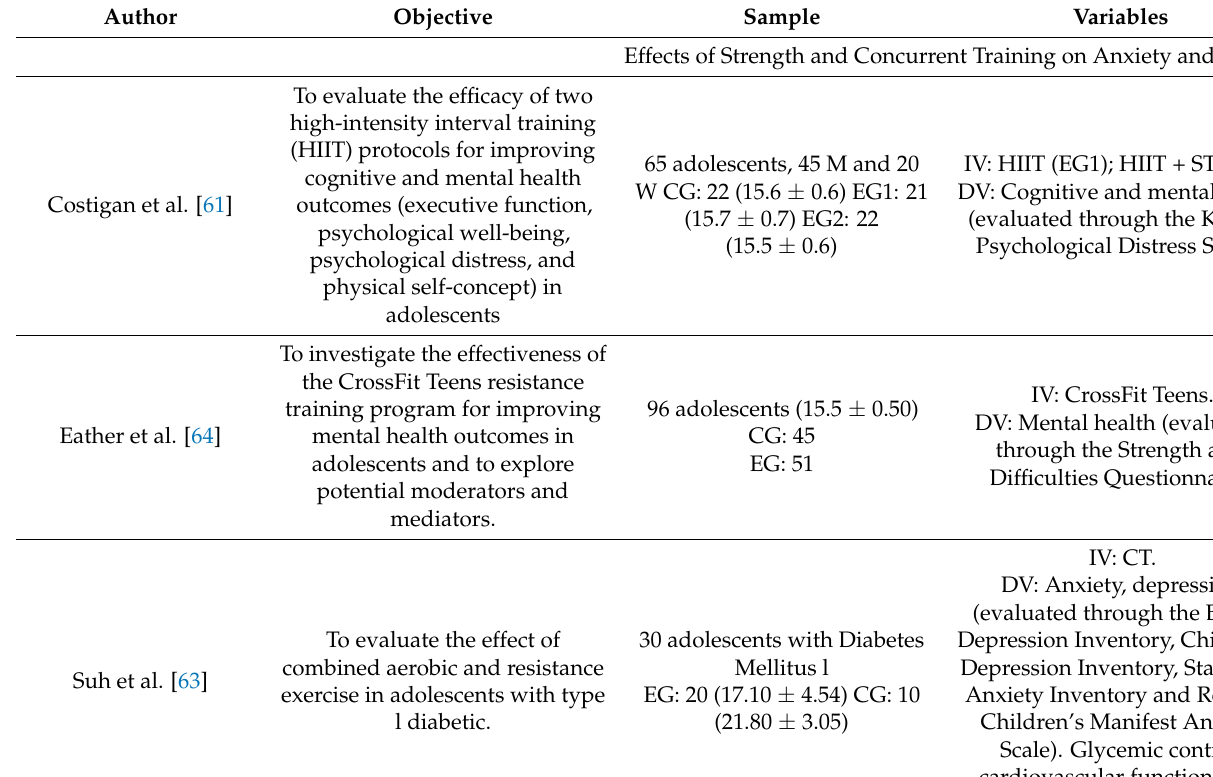
Table 1. Characteristics of the studies included in the systematic review and